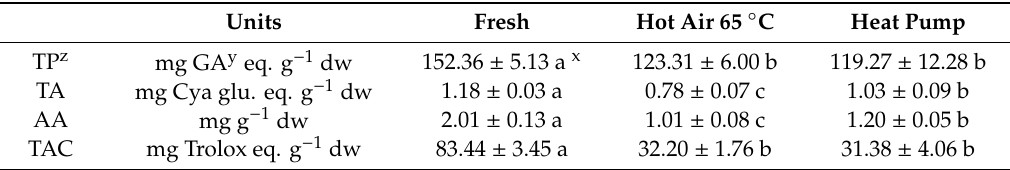
Table 3. Total phenolic (TP), total anthocyanin (TA), ascorbic acid (AA) content, and total antioxidant capacity (TAC) in fresh raspberry fruit grown in Garfagnana (Italy), and after conventionally hot air-drying (65 ◦ C for 20 h) and heat pump-drying (35 ◦ C for 2 d). Each value is the mean of three replicates ± standard